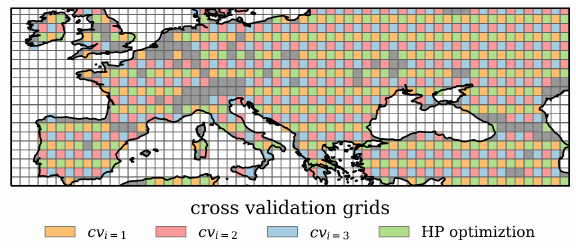
Figure 2. Regional example of the data splitting for the hyperparameter tuning and cross-validation. The grid-cells are split into four mutually exclusive, regular grids (colored). The grid-cells of each set are separated by a buffer to reduce the spatial autocorrelation between the samples. The samples of each grid were then split randomly into 5 sets of which one was used for testing and the remaining four were iterated such that each set was used as validation set once. One of the four grids was used for hyperparameter optimization. Following this scheme, three separate cross-validations ( cv i ∈{ 1 , 2 , 3 } ) are performed, each yielding four predictions on the test set. Note that some grid-cells are masked out (grey), see Section 2.7 for more details.